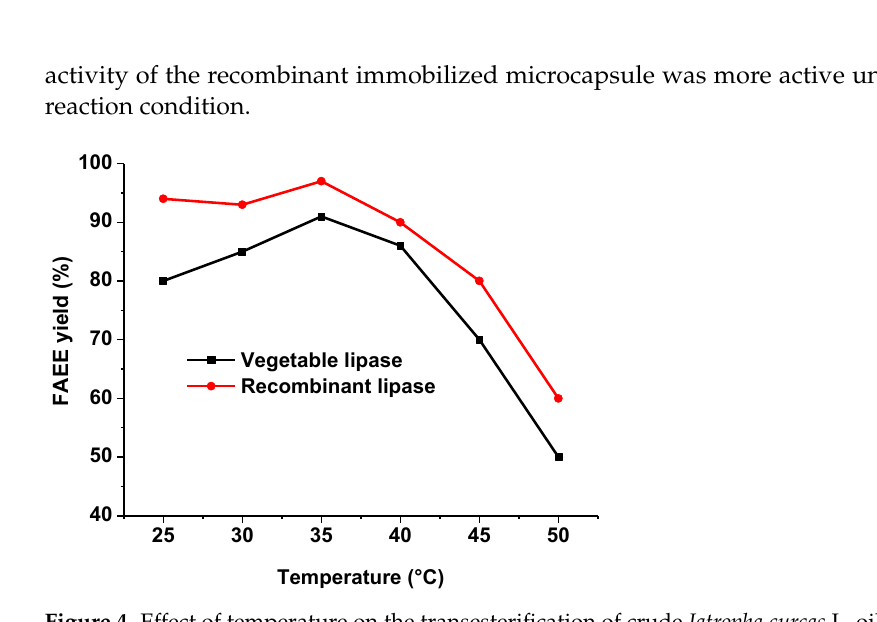
Figure 4. Effect of temperature on the transesterification of crude Jatropha curcas L. oil using immobilized lipase catalysts. Experimental parameters: Jatropha oil 10 g, ethanol to oil mass ratio 10, water 10 wt%, catalyst mass 4.2 g, mixing intensity 3 g RCF, pH value 7.5, and 24 h reaction time.